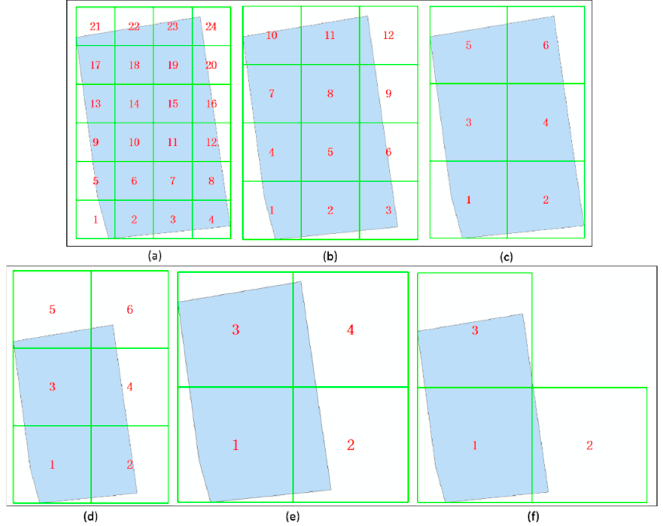
Figure 3. The di ff erent sized super-grids in the tested field: ( a ) 200 × 200 m 2 , ( b ) 300 × 300 m 2 , ( c ) 400 × 400 m 2 , ( d ) 500 × 500 m 2 , ( e ) 600 × 600 m 2 , and ( f ) 700 × 700 m 2 . The number is the identification (ID) of the